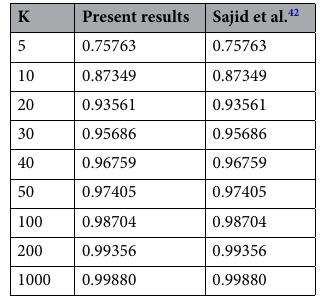
Table 3. Validation of numerical result of C f with the published work of Sajid et al. 31 for the variation of curvature K.